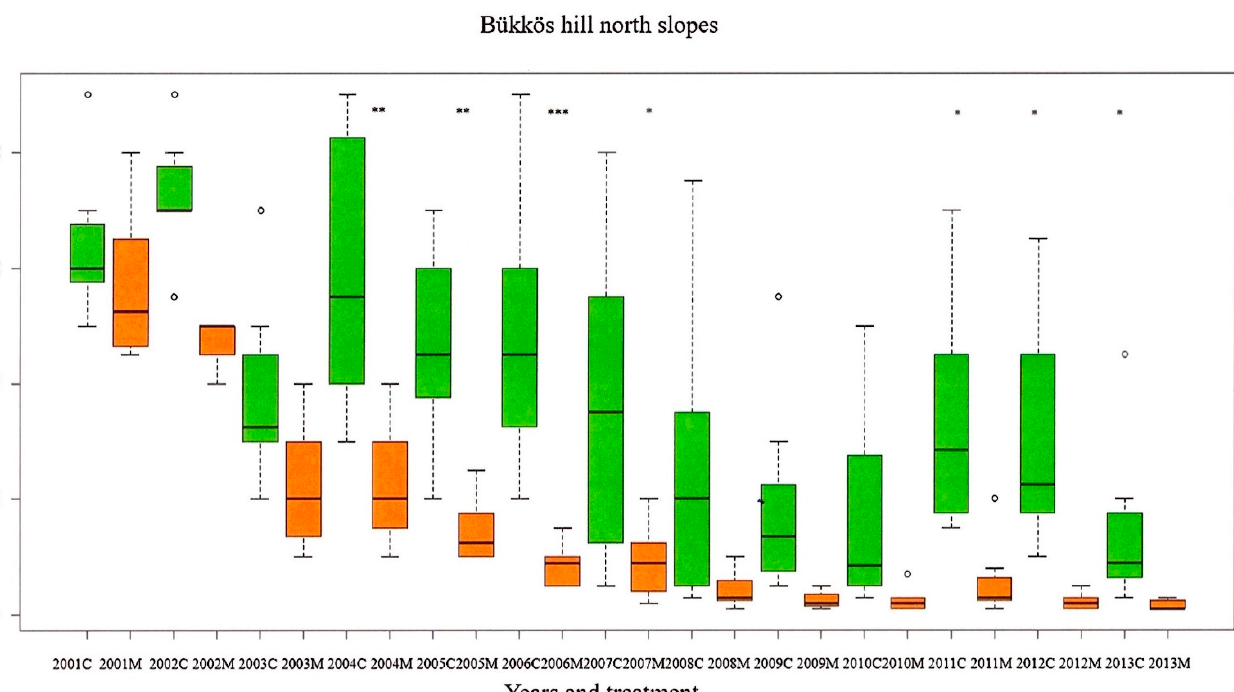
Figure 3. Change of cover of C. epigejos in the mown and control plots on the Bükkös hill northern slopes during the 2001–2013 period, mown plot = red boxes, control plot = green boxes. Empty circles = outliers. Significant differences between mown and control plots in the same year are marked by * ( p < 0.05) ** ( p < 0.01) *** ( p < 0.005).